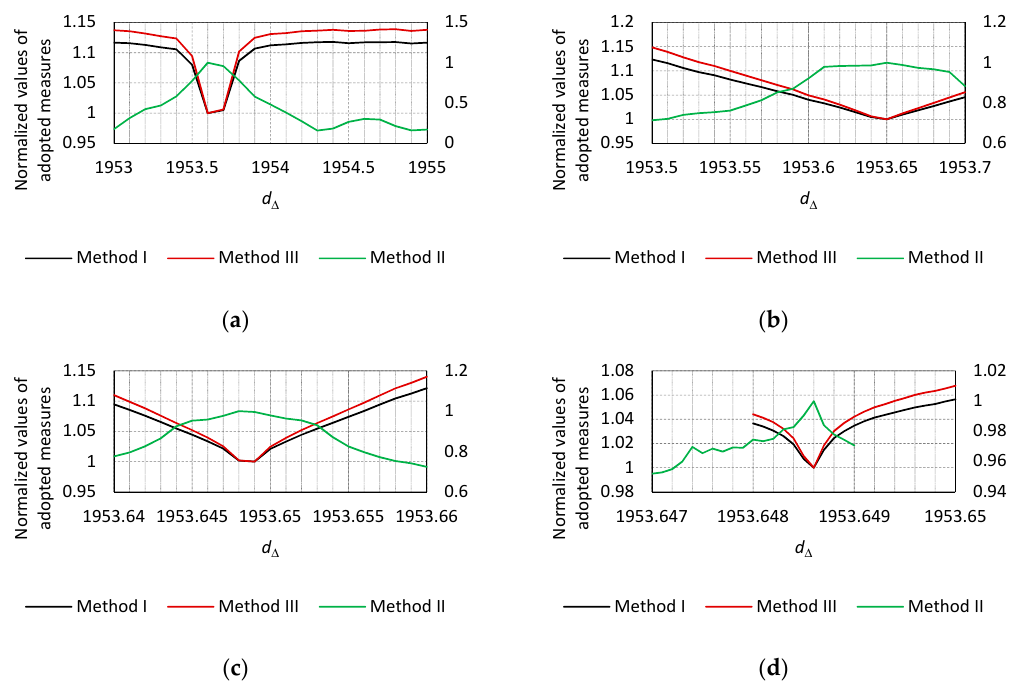
Figure 19. The normalized values of the adopted measures (method I, II and III) calculated in domain of image line length d ∆ for the accuracy ( a ) ∆ = 0.1, ( b ) ∆ = 0.01, ( c ) ∆ = 0.001 and ( d ) ∆ = 0.0001 (for the original image shown in Figure 7b).